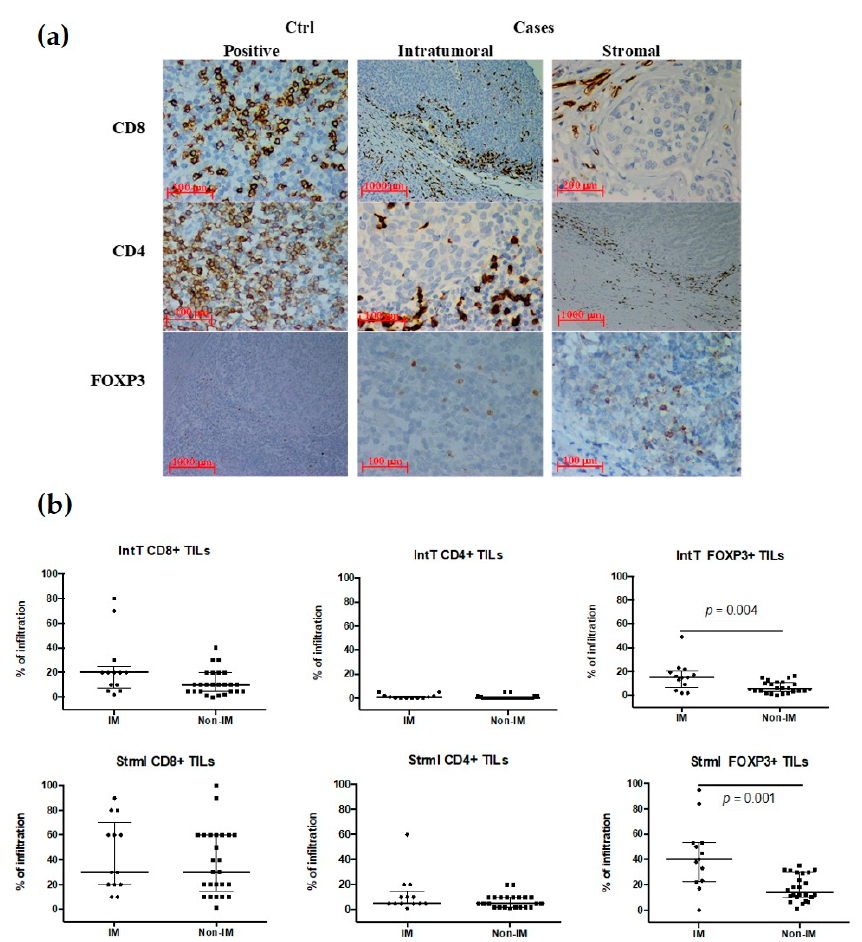
Figure 1. Tumor infiltration lymphocytes (TILs) in the immunomodulatory (IM) subtype vs. non-IM subtype. ( a ) Representative images of immunohistochemistry depicting both intratumoral (intT) and stromal (strml) infiltrating lymphocyte subpopulations (CD4+ (ctrl ×40, intT ×40, strml ×4); CD8+ (ctrl ×40, intT ×4, strml ×20), and FOXP3+ (ctrl ×4, intT ×40, strml ×40)) in TNBC biopsies. ( b ) Scatter plots (percentages) compare median and data distribution between IM vs. non-IM subtypes, both intT and strml per lymphocytes subpopulation (with interquartile range bars and the median); differences assessed using the Mann–Whitney U test; statistically significant differences are shown in each plot. Ctrl: controls.